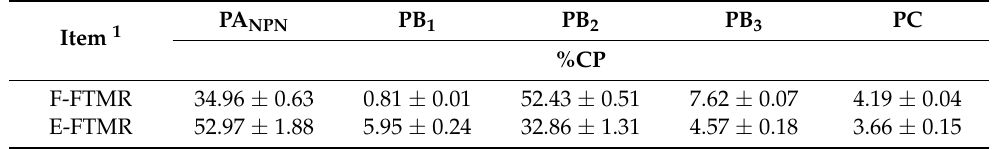
Table 4. The Cornell Net Carbohydrate and Protein System (CNCPS) proportion of alfalfa, fresh- alfalfa and ensiled-alfalfa FTMR before fermentation.